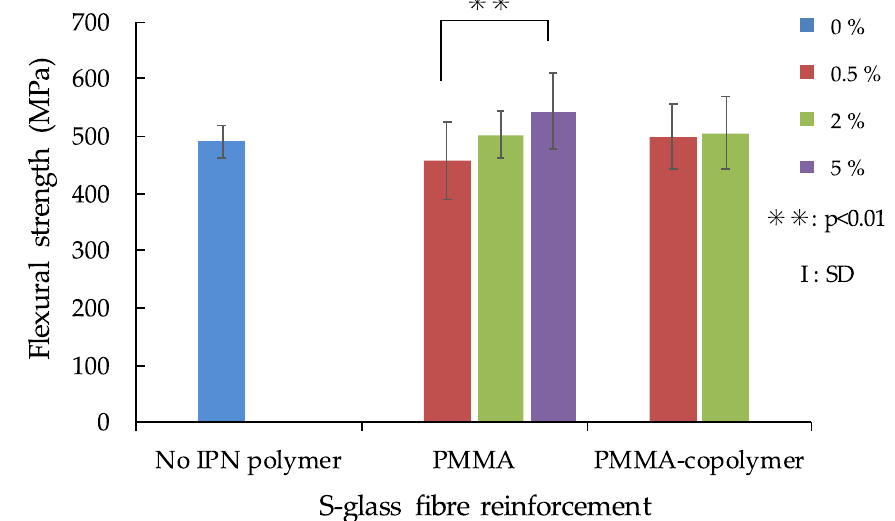
Figure 3. Flexural strength of IPN thermoplastic resin with S-glass fibre reinforcement.